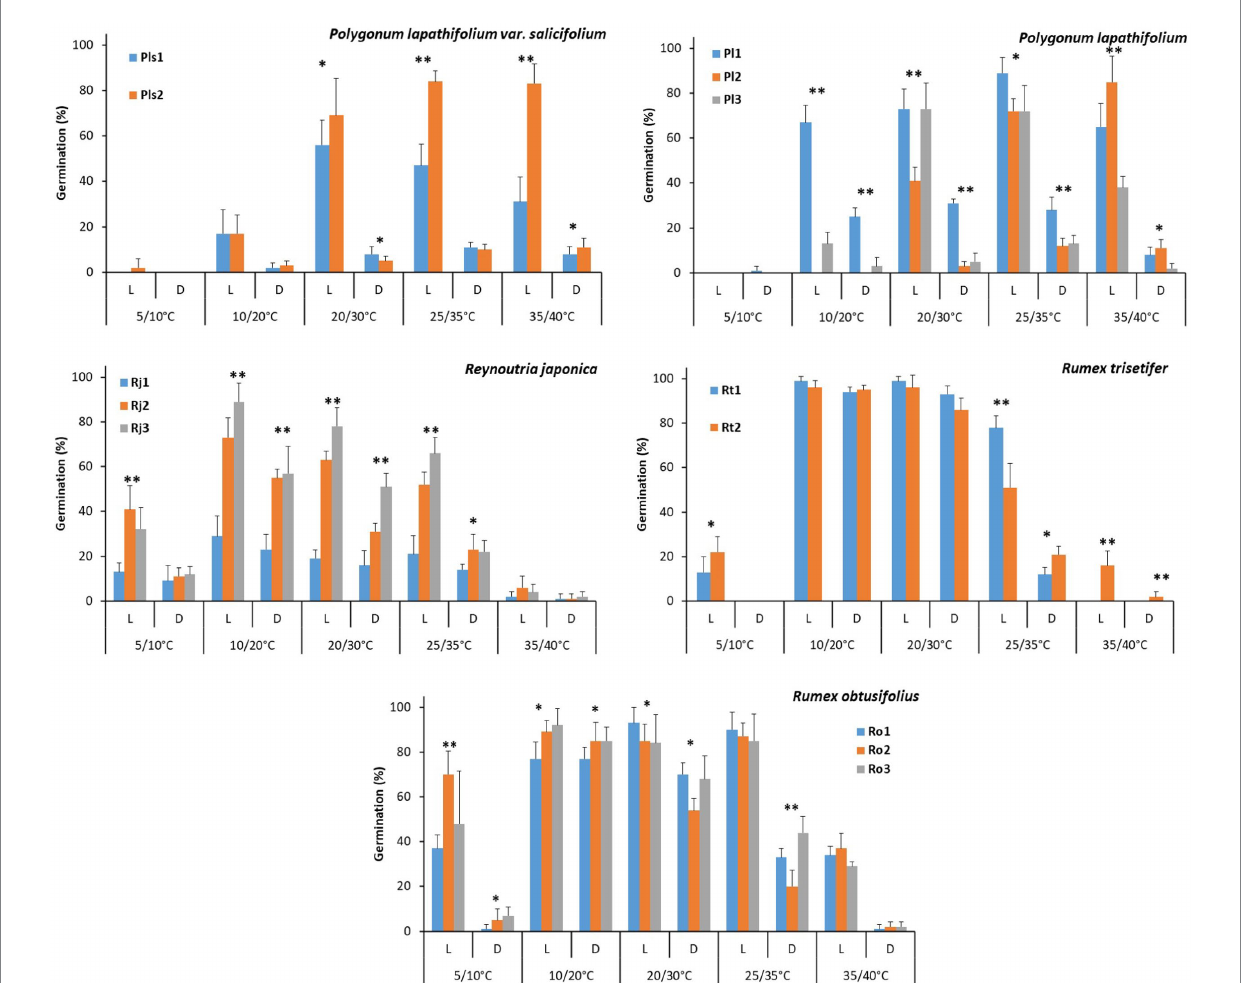
FIGURE 2 Influence of population, incubation temperatures, and photoperiod on mean seed germination percentage of five Polygonaceae species. Significance values of different factors are indicated in Table 2. Bars with * or ** signs indicate germination percentage differed significantly ( P < 0.01 or < 0.001) between and /or among the populations at particular incubation